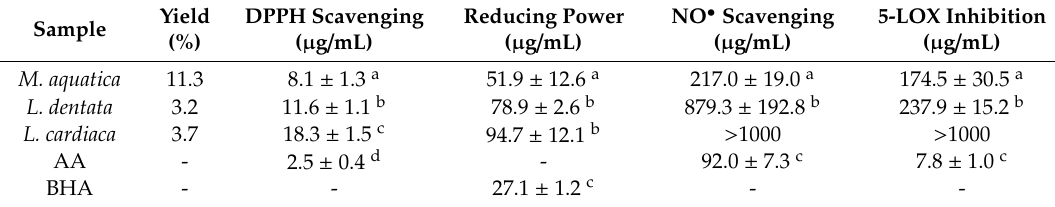
Table 1. Yield of extraction (%), antioxidant and anti-inflammatory activities (EC 50 , µ g / mL) of M. aquatica, L. dentata and L. cardiaca extracts.